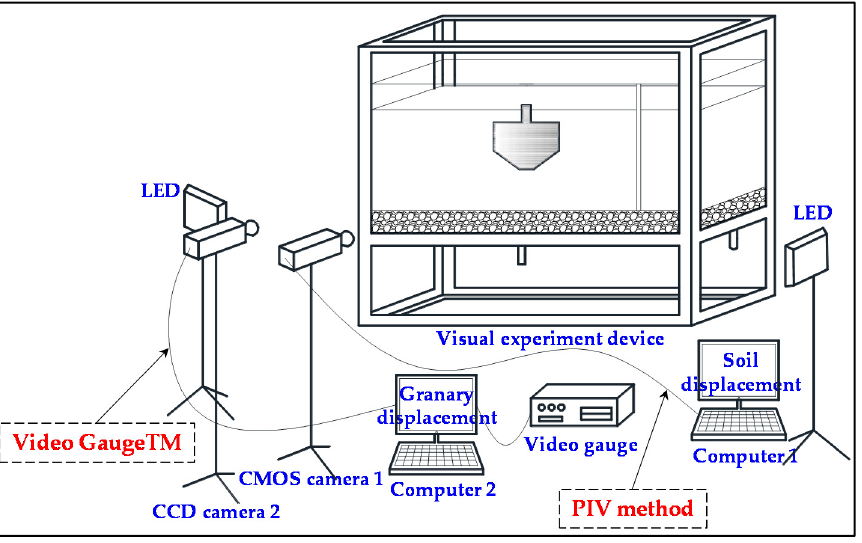
Figure 2. Non-contact experiment system.